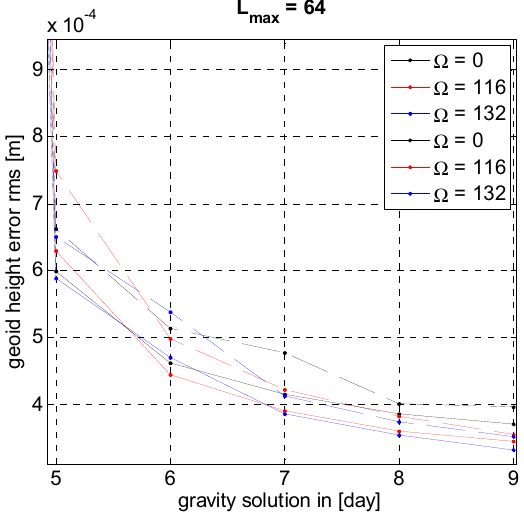
Figure 9. Global error RMS in terms of geoid height for odd (solid line) and even (dashed line) parities (inline scenarios a and b of the Table 2, respectively) for the gravity solutions up to maximum spherical harmonic degree and order 64. Different colors stand for different Ω .